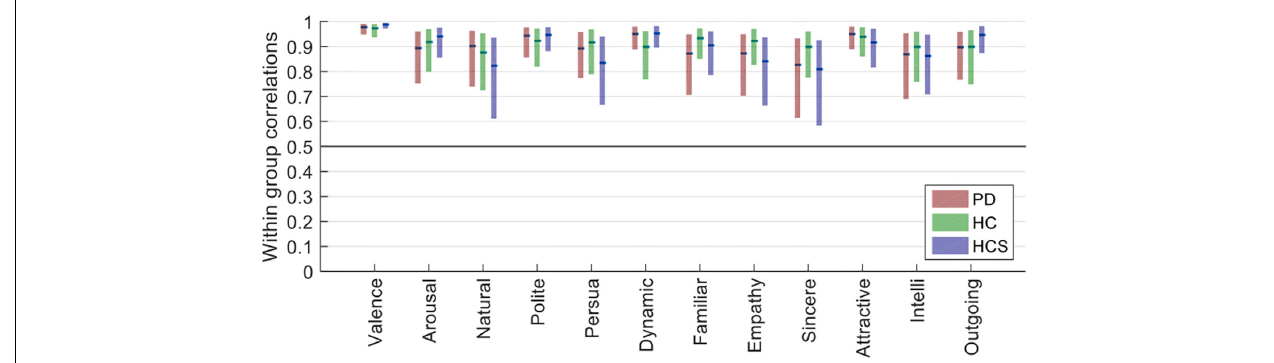
FIGURE 2 | Plots of the within-group reliability for each dimension of the three participant groups (bars show the estimated median of the bootstrapped sample distribution, and the boxes show the 95% confidence intervals estimated from